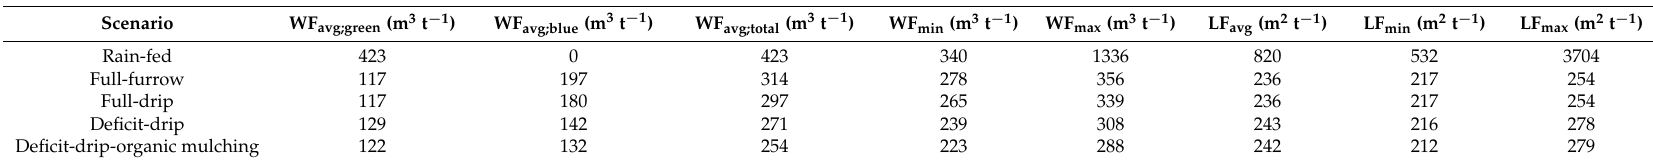
Table 2. Green and blue water footprint (WF) and average, minimum and maximum total WF and land footprint (LF) of mulberry leaf production per metric ton of leaf for five different scenarios. Average WF and LF are production weighted over the period 1986–2016.